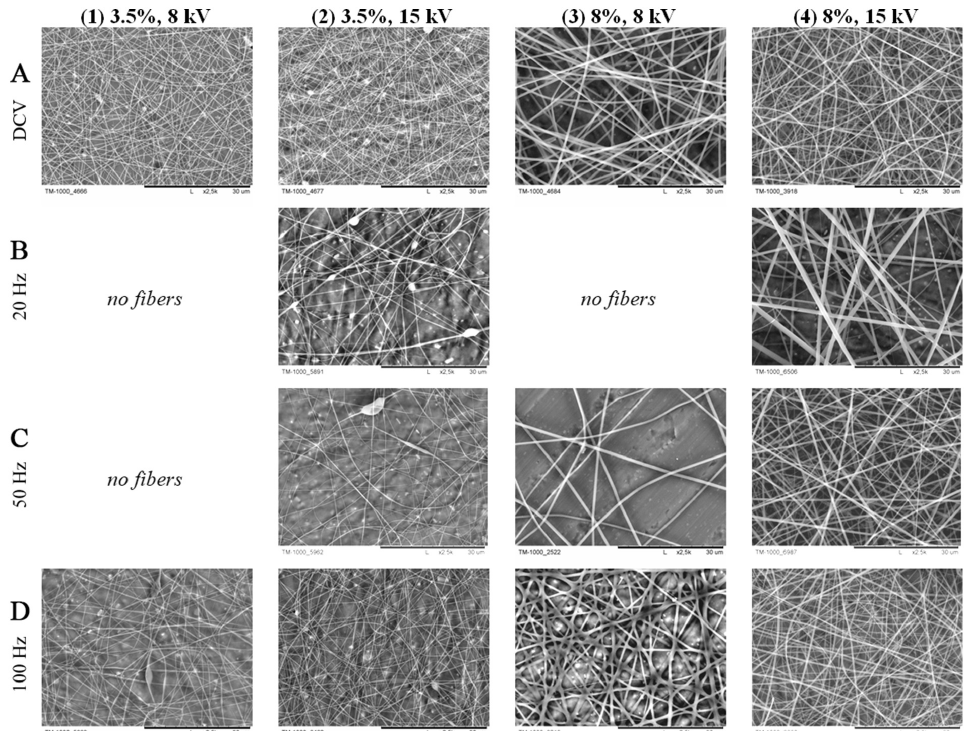
Figure 8. FESEM images of PVP nanofiber mats (scale bar = 30 µ m) ; ( A ) DC voltage; ( B ) pulsed voltage at 20 Hz; ( C ) pulsed voltage at 50 Hz; ( D ) pulsed voltage 100 Hz. Reprinted from ref.